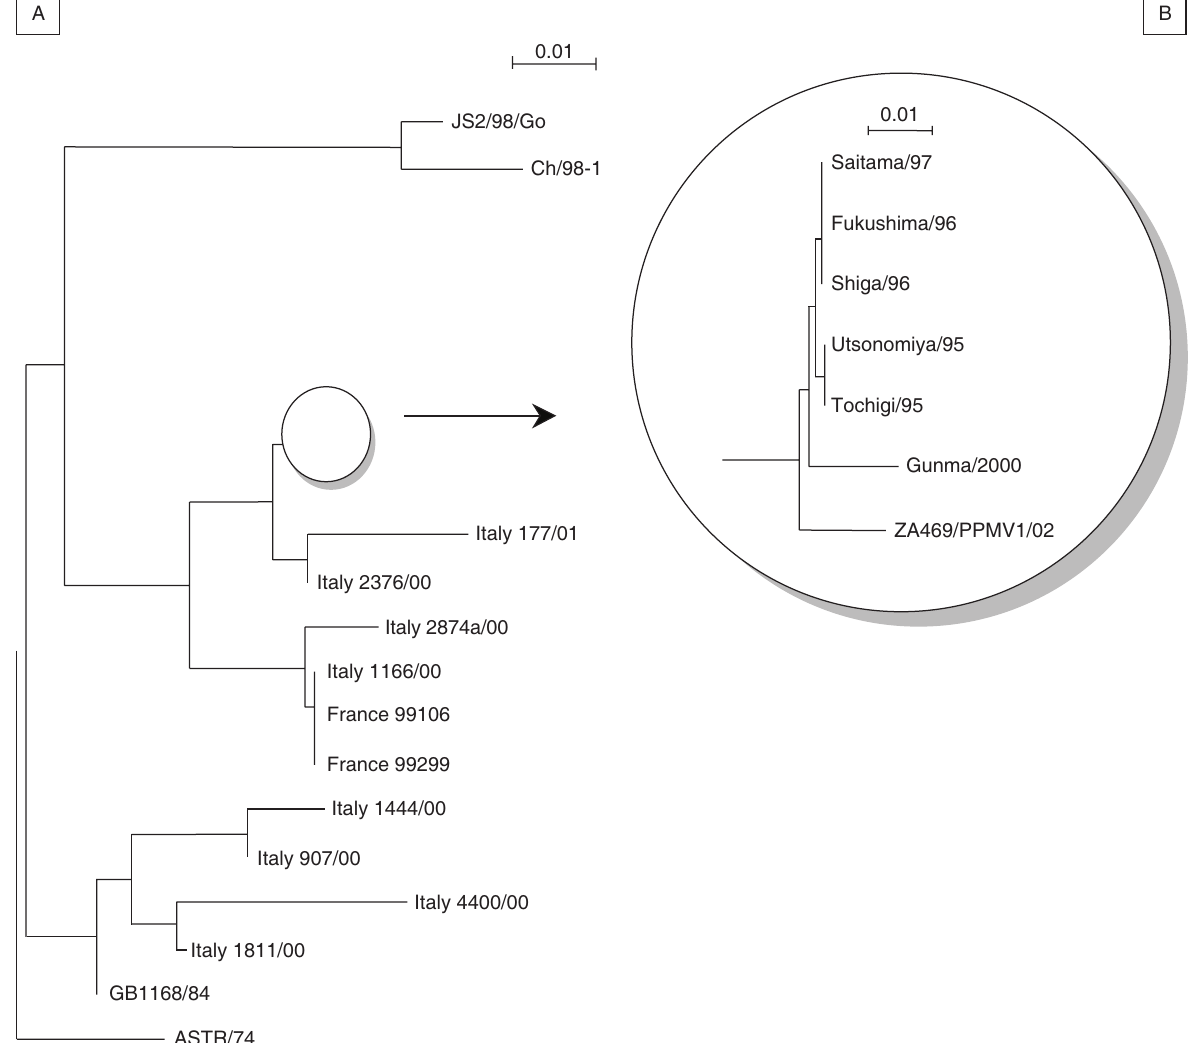
FIG. 1 Phylogenetic relationships of PPMV-1 isolates in Table 1 based on (A) nucleotides 269 to 374 (106 bp) of the F protein gene and (B) nucleotides 1 to 374 of the F protein gene, with insert showing higher resolution of the phylogenetic relationship of some of these